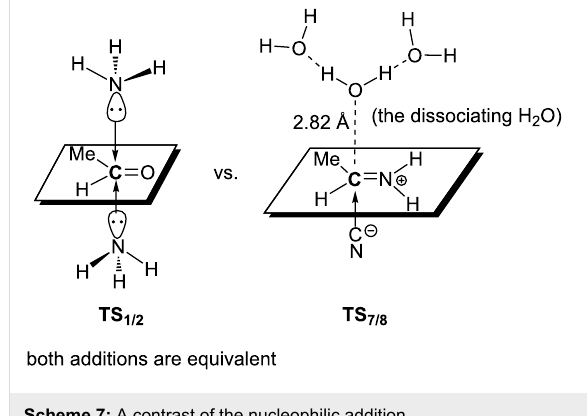
Scheme 7: A contrast of the nucleophilic